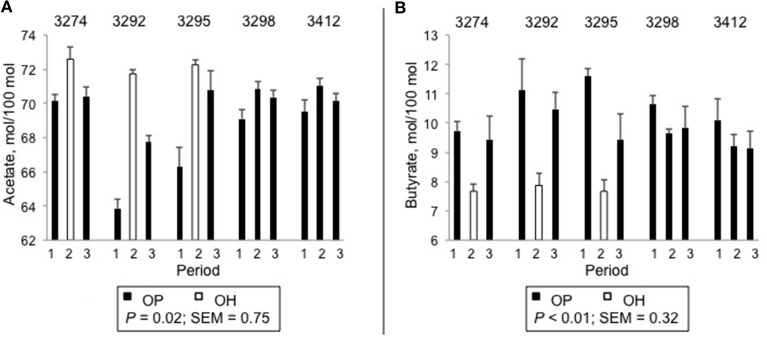
Molar percentages of ruminal acetate (A) and butyrate (B) in individual heifers across periods. Diets were orchardgrass pasture (OP) and orchardgrass hay (OH) harvested from at the vegetative stage of growth. Comparisons reflect differences between OP and OH in heifers that received both diets. s.e.m. = standard error of the mean.